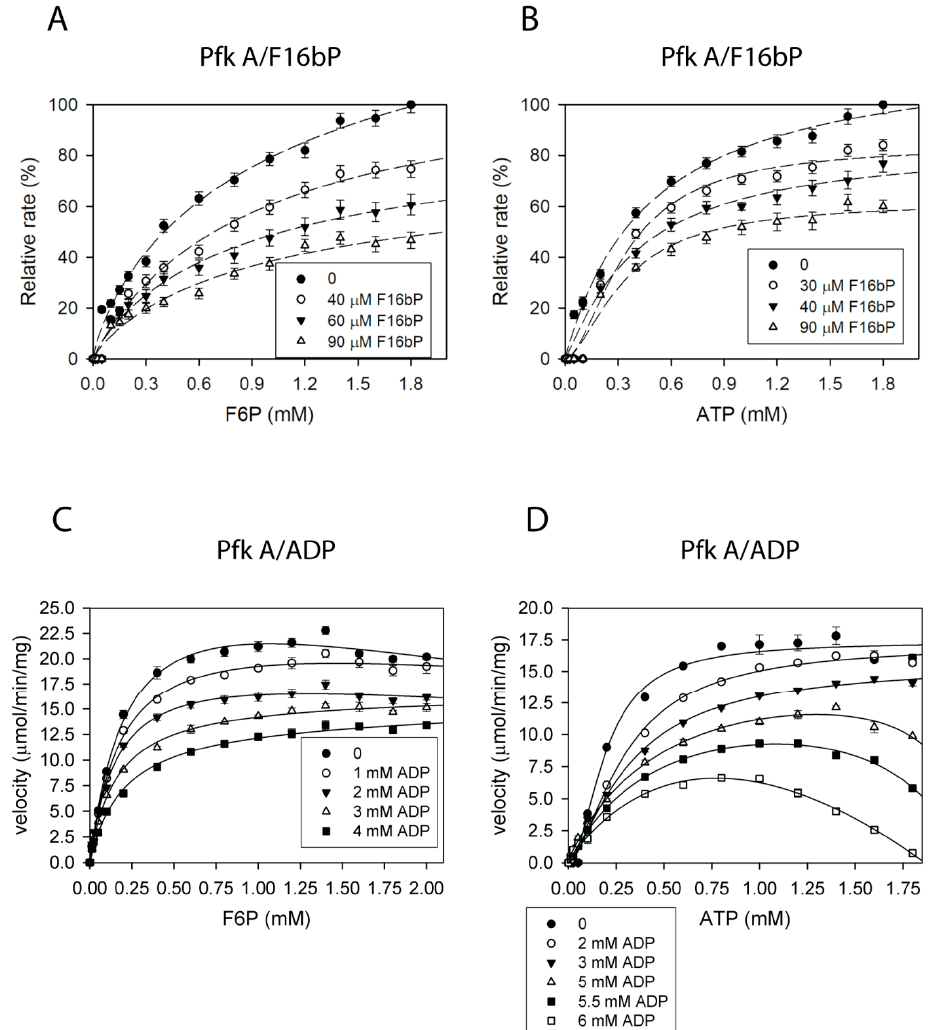
Figure 5. The feedback inhibition of Pfk A by F16bP ( A , B ) and ADP ( C , D ) measured at 1 mM ATP ( A , C ) or F6P ( B , D ) and varied concentration of a second substrate. Individual reaction mixtures of the coupled enzyme system II (see Materials and Methods) containing appropriate concentrations of F6P and ATP in the absence of phosphoenolpyruvate (PEP) were incubated with 20 nM Pfk A for 5 min at 30 °C. Thereafter, PEP was added to the 1 mM final concentration and the progress of the reaction was followed by measuring the absorbance at 340 nm. The average reaction velocities corresponding to the ratios of the formed ADP and starting ATP concentration in 5 min were plotted in graphs ( A , B ). For better illustration the velocities were normalized (100% determines the maximum achievable velocity). The dashed lines indicate the increasing trend. The reactions were run according to Materials and Methods using coupled enzyme assay I ( C , D ). The data were fitted to Equations (2) and (4).